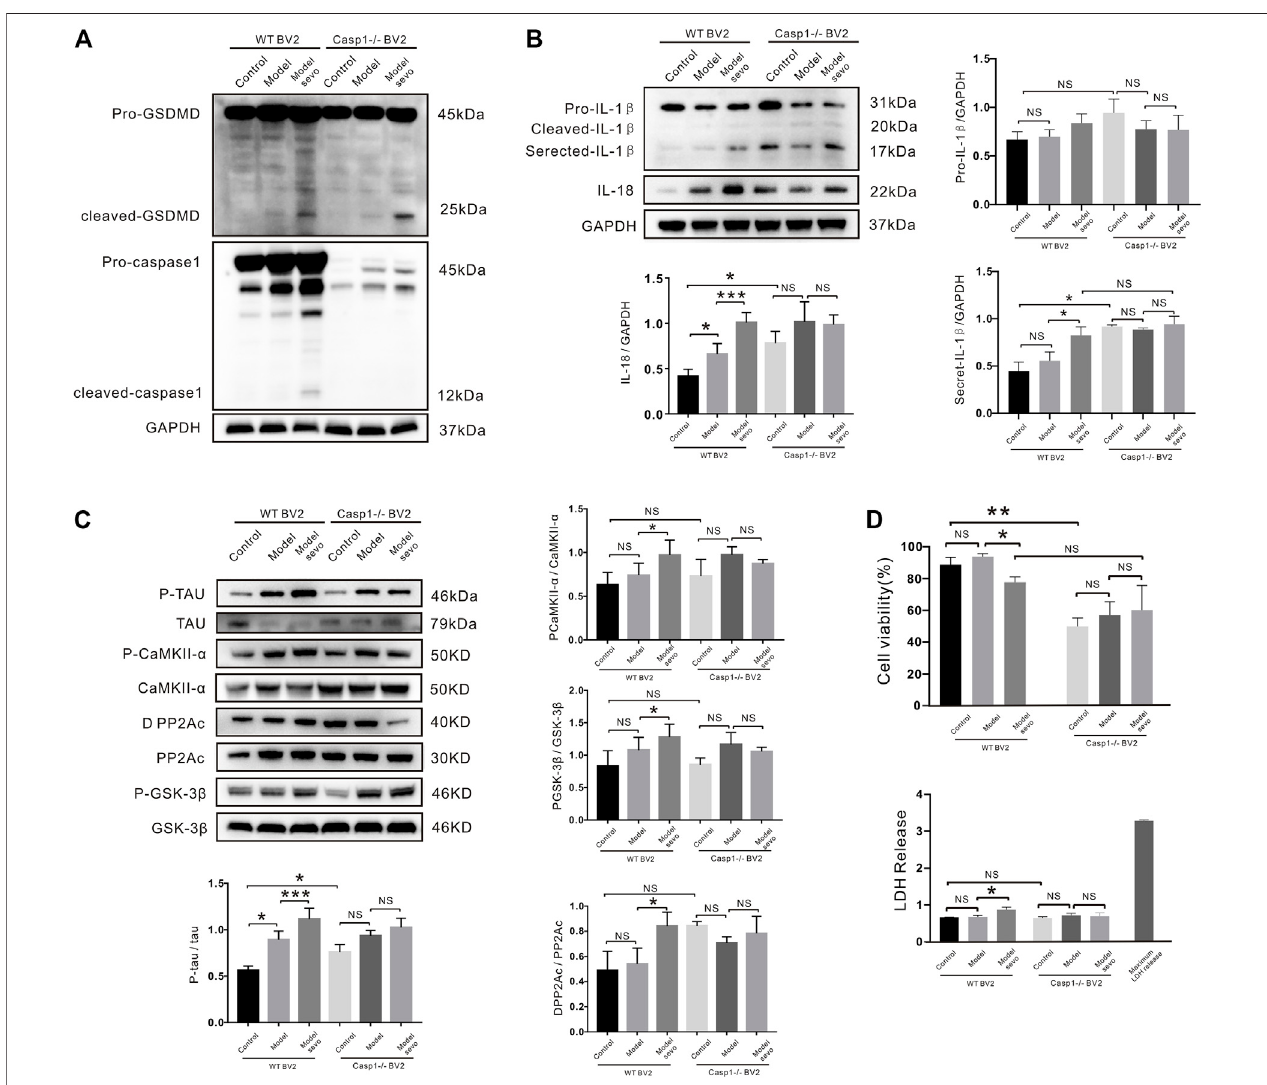
FIGURE 6 | Casp1 knockout alleviates sevo fl urane-induced pyroptosis and Alzheimer ’ s disease (AD) development. (A) Western blotting analysis of cleaved gasdermin D (GSDMD) and caspase-1 in wild-type (WT) and caspase-1 − / − BV2 cells treated with 4% sevo fl urane for 6 h. (B) Immunoblot analysis of, secreted IL-18, secreted IL-1 β , induced by sevo fl urane in WT and caspase-1 − / − BV2 cells. Protein band intensity was quanti fi ed using ImageJ software. (C) P-tau and tau-related phosphatases were detected by Western blotting analysis. (D) Lactate dehydrogenase (LDH) release and Cell Counting Kit-8 (CCK-8) assays of LDH activity and cell viability in WT and NLRP3 − / − BV2 cells. *** p < 0.001, ** p < 0.01, * p < 0.05.